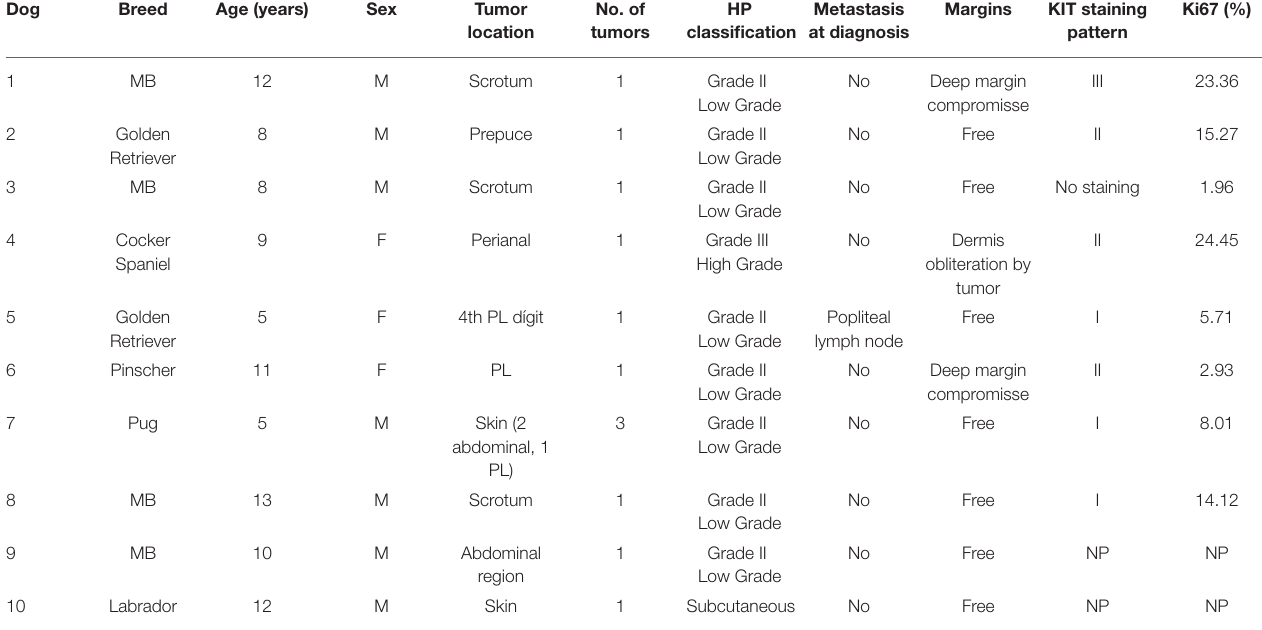
TABLE 1 | Signalment and tumor characteristics of dogs treated with 2-AEH2F. Dog Breed Age (years) Sex Tumor